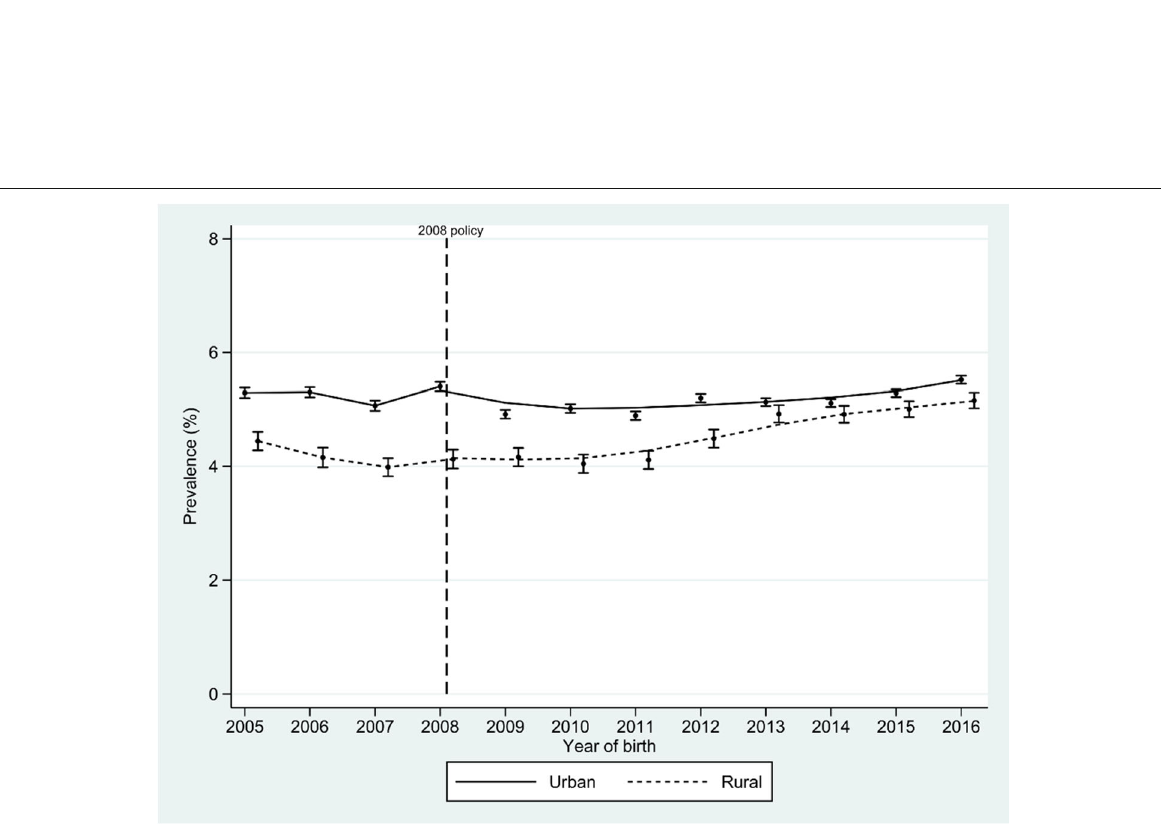
Fig. 2 Trends in prematurity prevalence by year and area of residence. Peru, 2005 – 2016. Dots represent proportion with low birthweight (g) and vertical lines represent 95% confidence intervals for the